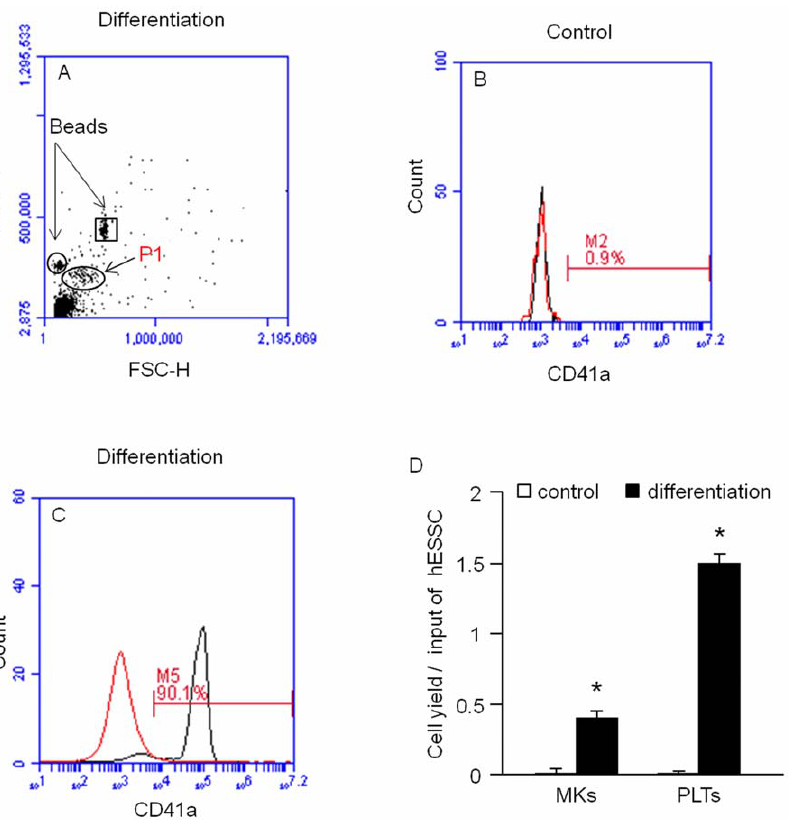
Figure 5. Analysis of PLT production from hESSC-differentiated MKs. Representative flow cytometric plots show the location of PLT population (A, oval indicates the PLT population; circle and square indicate respective locations of 2 m m and 4 m m calibration beads) and the percentage of CD41a expression of the cells gated on P1 (B: control, C: differentiation; left curves: isotype controls; right curves: antibodies). D, summarized data of MK and PLT yield per input of hESSC. Data are expressed as mean 6 SEM, *p , 0.01, control versus differentiation, n=4/group.